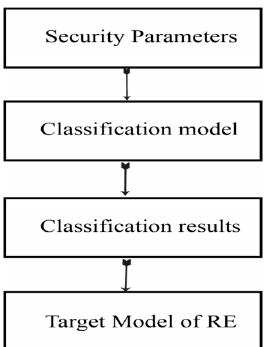
Figure 1. Workflow for the classification of Requirement Engineering Figure 1 . Workflow for the classification of Requirement Engineering models .